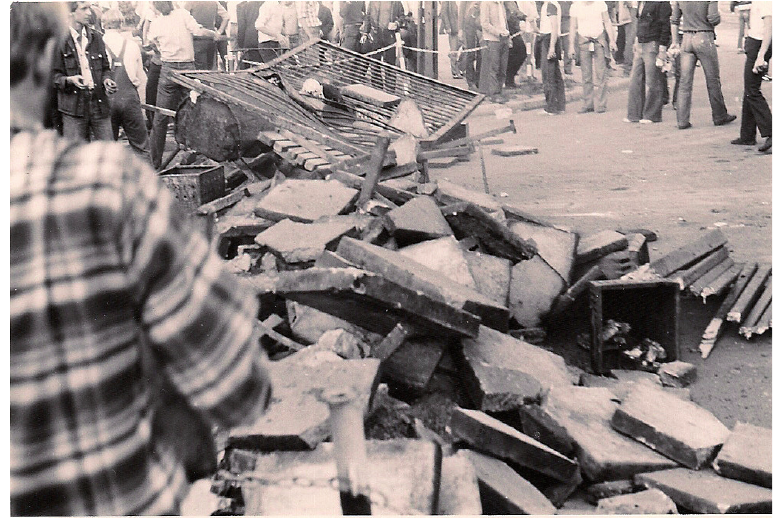
Fig. 3. 31 sierpnia 1982 r. w Nowej Hucie; in the possesion of Zdzis ł aw